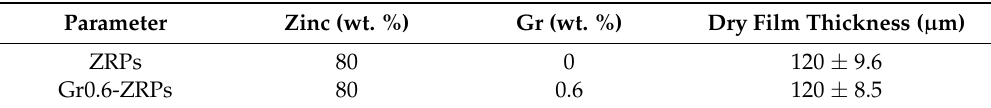
Table 1. Specification of different